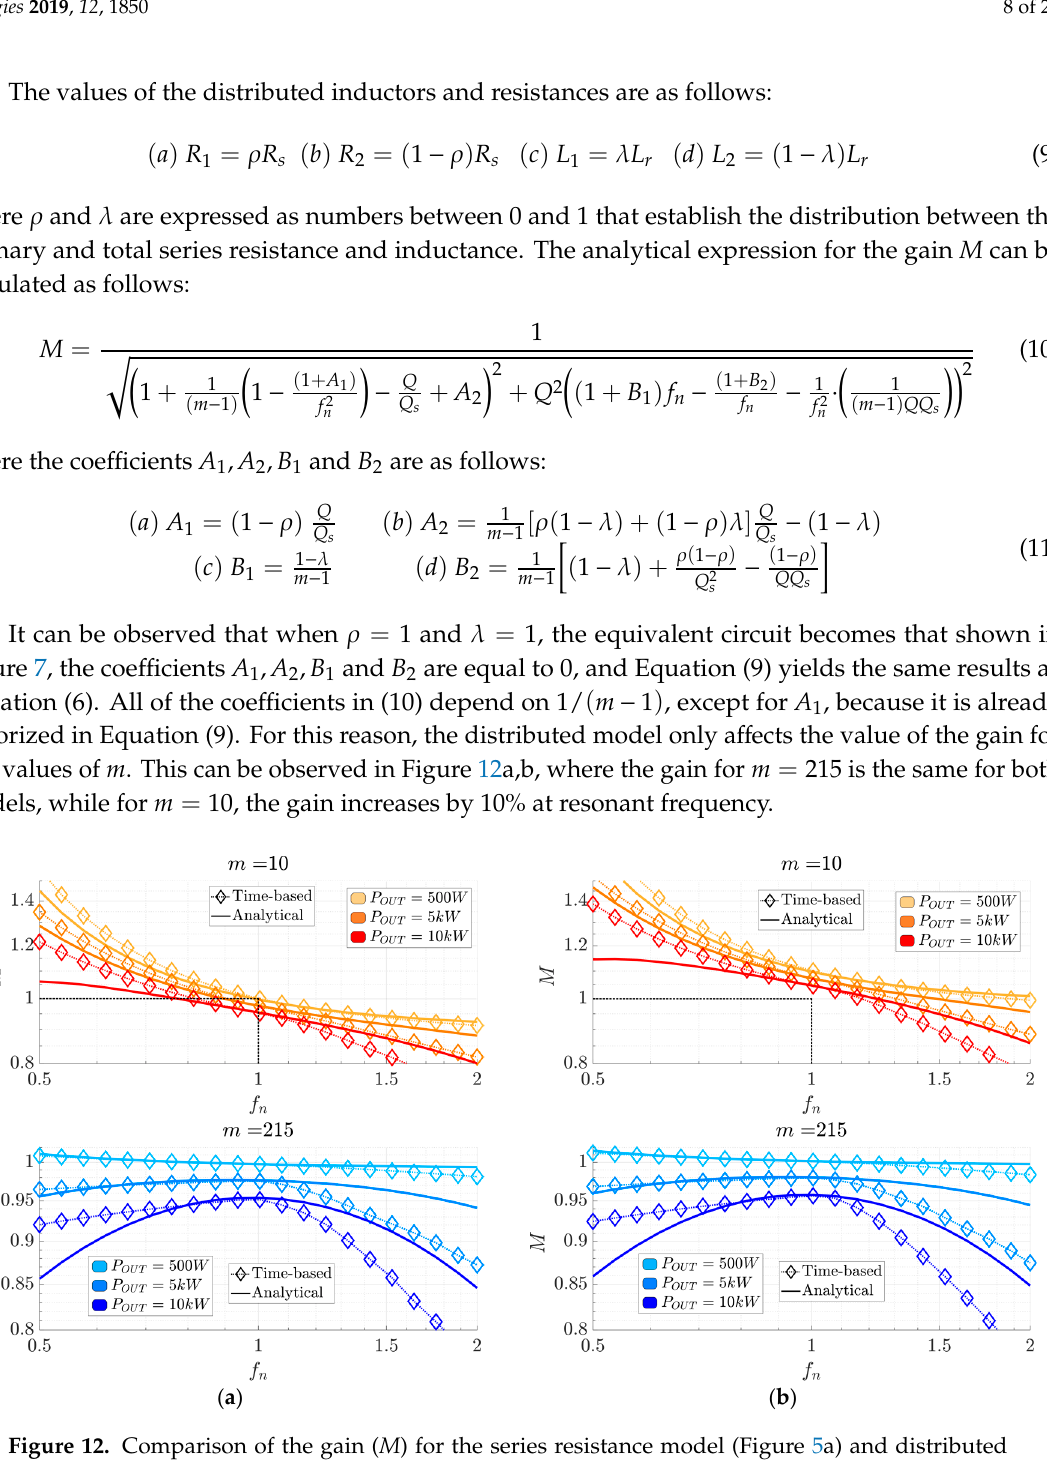
Figure 12. Comparison of the gain ( 𝑀 ) for the series resistance model (Figure 5a) and distributed model (Figure 5b) with the FHA model and time-based simulations: ( a ) series resistance model gain at different powers and inductance ratios (Figure 6); ( b ) distributed model gain at different powers and inductance ratios.